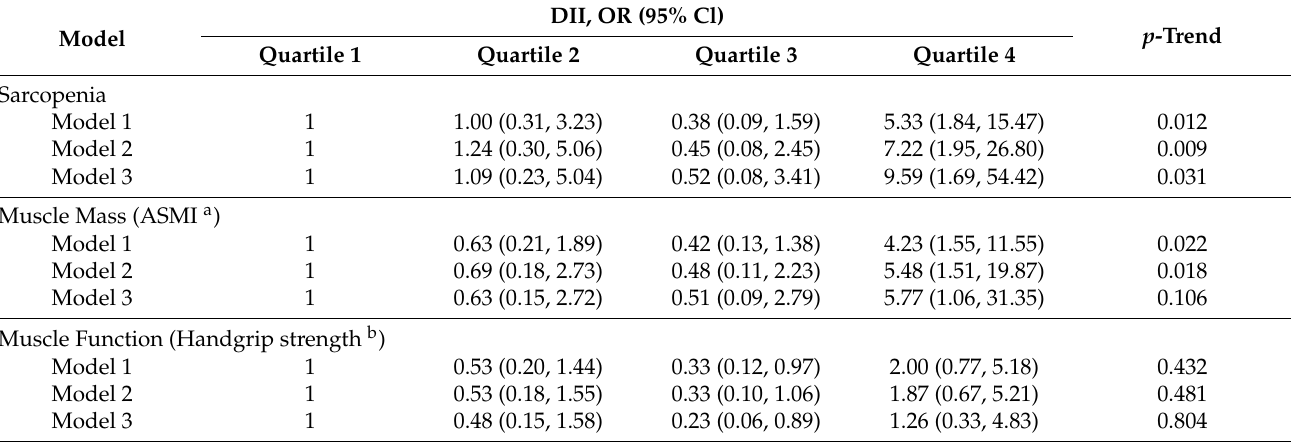
Table 3. Multivariable adjusted models (95% confidence intervals) for the risk of